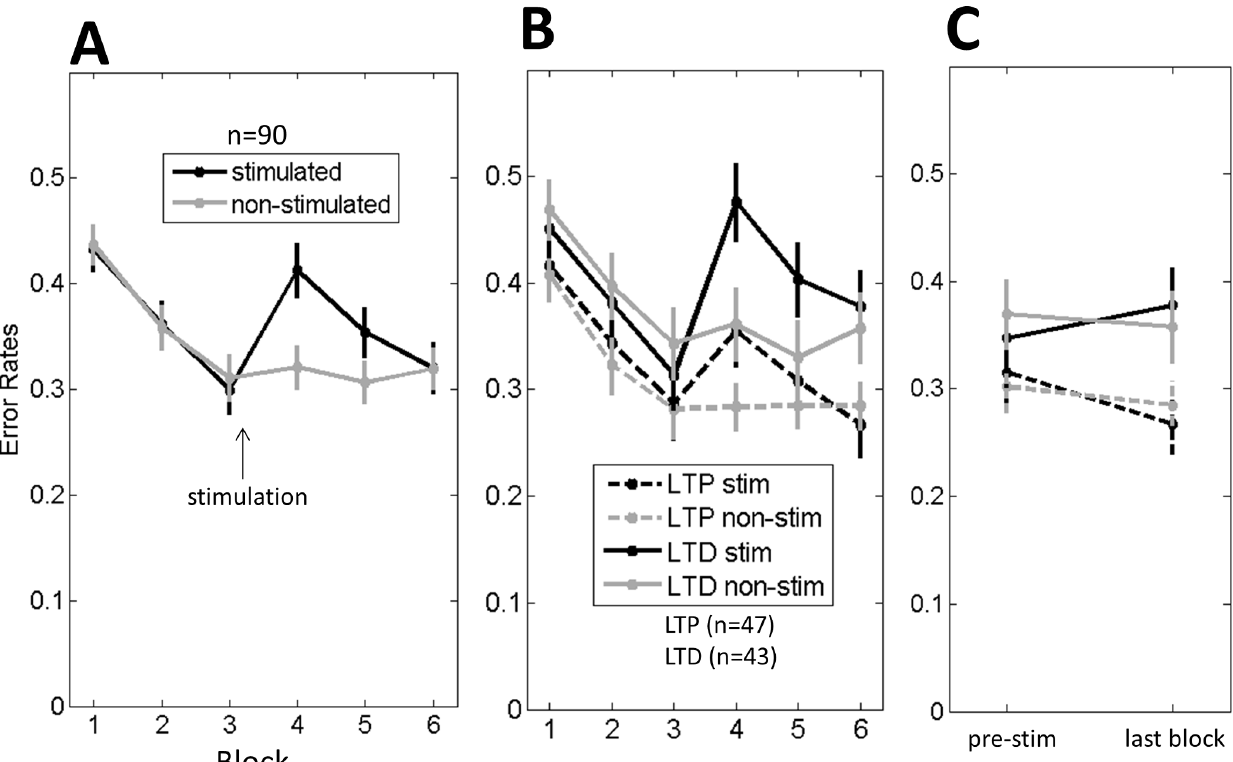
Fig 3. Experiment 2 (unilateral stimulation). A) Error Rates on ‘ competitive trials ’ for the stimulated vs non-stimulated hemifield (LTP-like and LTD-like stimulation collapsed). B) Error rates on ‘ competitive trials ’ for each stimulation group and hemifield: LTP stim = errors in the stimulated hemifield for the LTP-like group; LTP non-stim = errors in the non-stimulated hemifield for the LTP-like group; LTD stim = errors in the stimulated hemifield for the LTD-like group; LTD non-stim = errors in the non-stimulated hemifield for the LTD-like group. C) Stimulation effects outside the “ performance-disrupted window ” (i.e., block 6) compared to pre-stimulation performance (i.e. block 2 and 3). Error bars = +/- 1 SEM across subjects.